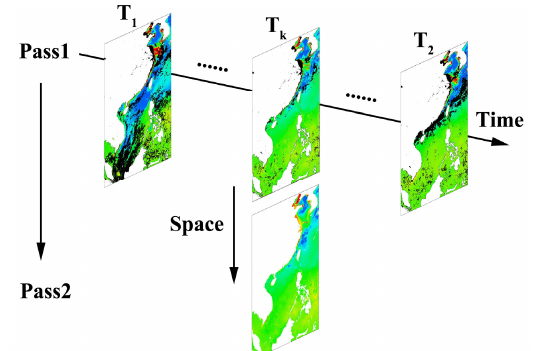
Figure 8. Spatiotemporal interpolation using CUDA